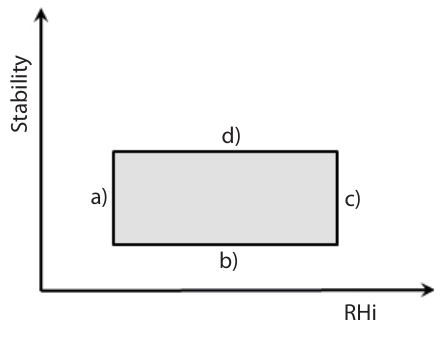
Fig. 13. Phase-diagram of possible conditions, for which thermal emission is an important cloud-building factor in dependence of the stability (statical and dynamical) and the RHi within an ISSR. The regions outside (b) and (c) accord to spontaneous cloud formation without an influence of radiation, whereas outside (a) and (d) the conditions supress any cloud formation within the simulation